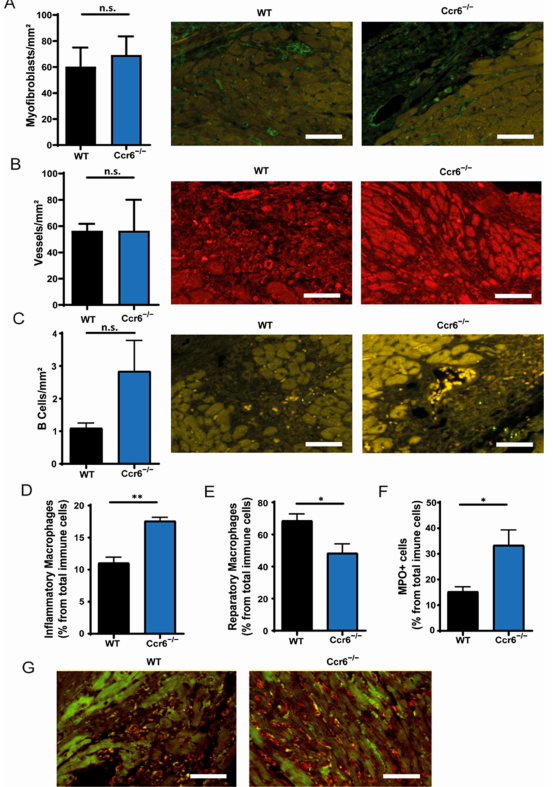
Figure 3. Deficiency of CCR6 results in the increased infiltration of inflammatory immune cells in the cardiac tissue after ischemia-reperfusion injury. ( A ) Quantification of the number of myofibroblast in the scar from Ccr6 − / − mice compared to wild-type mice 21 days after ischemia-reperfusion, including representative images of smooth-muscle actin (Green) staining. Scale bar = 50 µ m. ( B ) Quantification of the number of vessels in the scar from Ccr6 − / − mice compared to wild-type mice 21 days after ischemia-reperfusion, including representative images of CD31 (Red) staining. Scale bar = 50 µ m. ( C ) Quantification of infiltrating B cells, 2 days after ischemia-reperfusion in Ccr6 − / − mice compared to wild-type mice, including representative images of B220 (Yellow) stain- ing. Scale bar = 50 µ m. ( D – F ) Quantification of infiltrating inflammatory MPO+ immune cells ( D ), inflammatory macrophages ( E ) and reparatory macrophages ( F ), 2 days after ischemia-reperfusion in Ccr6 − / − mice compared to wild-type mice. ( G ) Representative images of MPO (Red) and Mac3 (Green) staining. All n = 3. * p < 0.05, ** p <